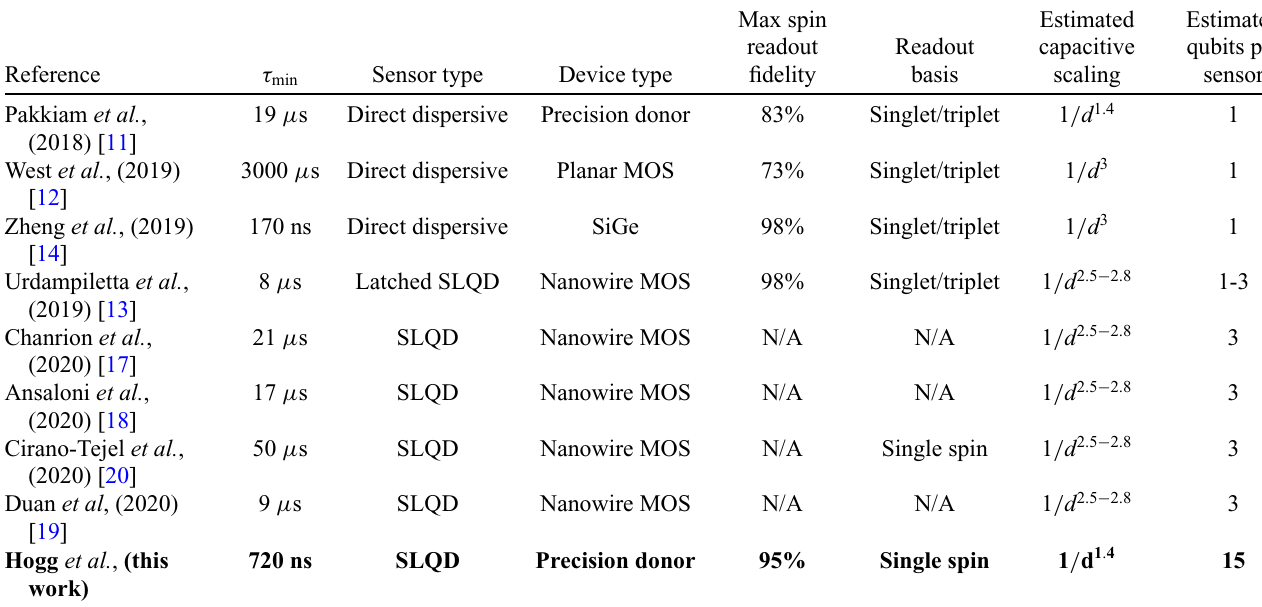
TABLE II. Improvement in estimated qubits per sensor compared to previous gate-based readout